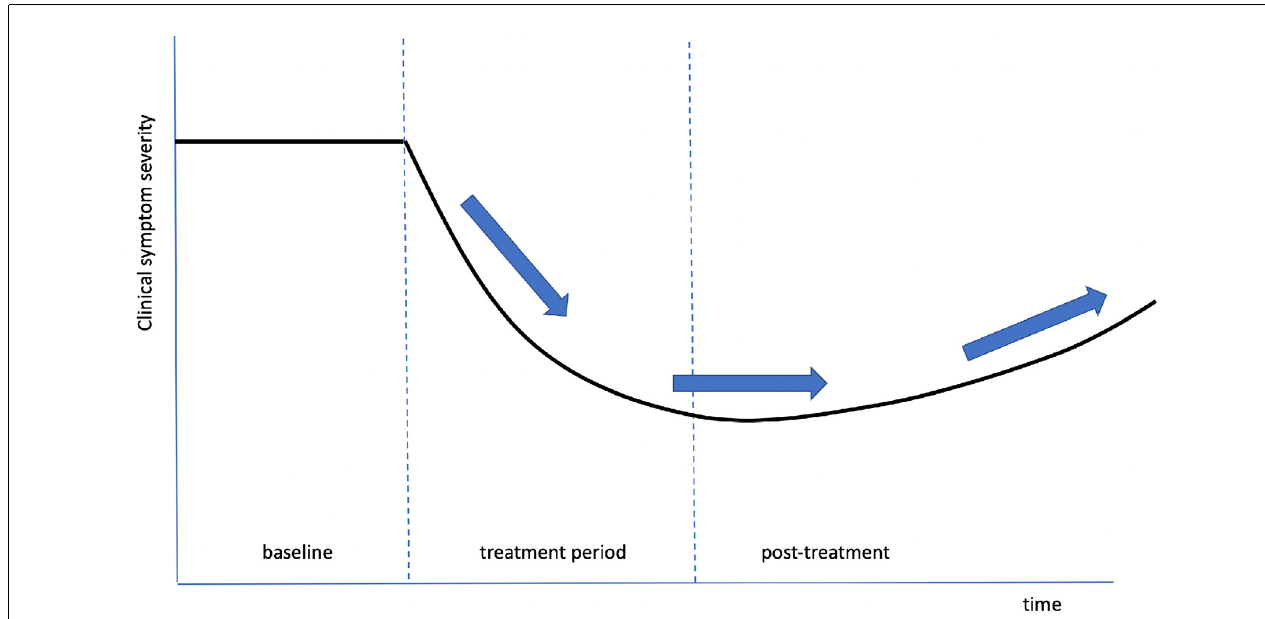
FIGURE 9 | An idealized composite graph of the response, over time, of multiple, different symptoms in Wilkinson et al. (2019). The same characteristic shape and time course was seen across independent measures, suggesting a common effect, possibly neuroplastic modification of the associated dysfunctional pathways. The arrows show initial improvement, a period of durable gains, and a slow return towards the